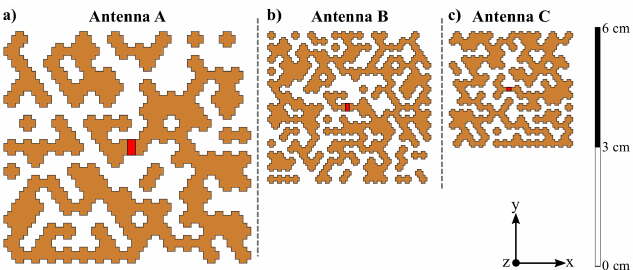
Figure 3. Different exemplary antennas generated with the proposed method. ( a ) 6 × 6 cm and 4 mm cross size, ( b ) 4 × 4 cm and 2 mm cross size, ( c ) 3 × 3 cm and 2 mm cross size. The red structure in the center of the respective antennas mark the